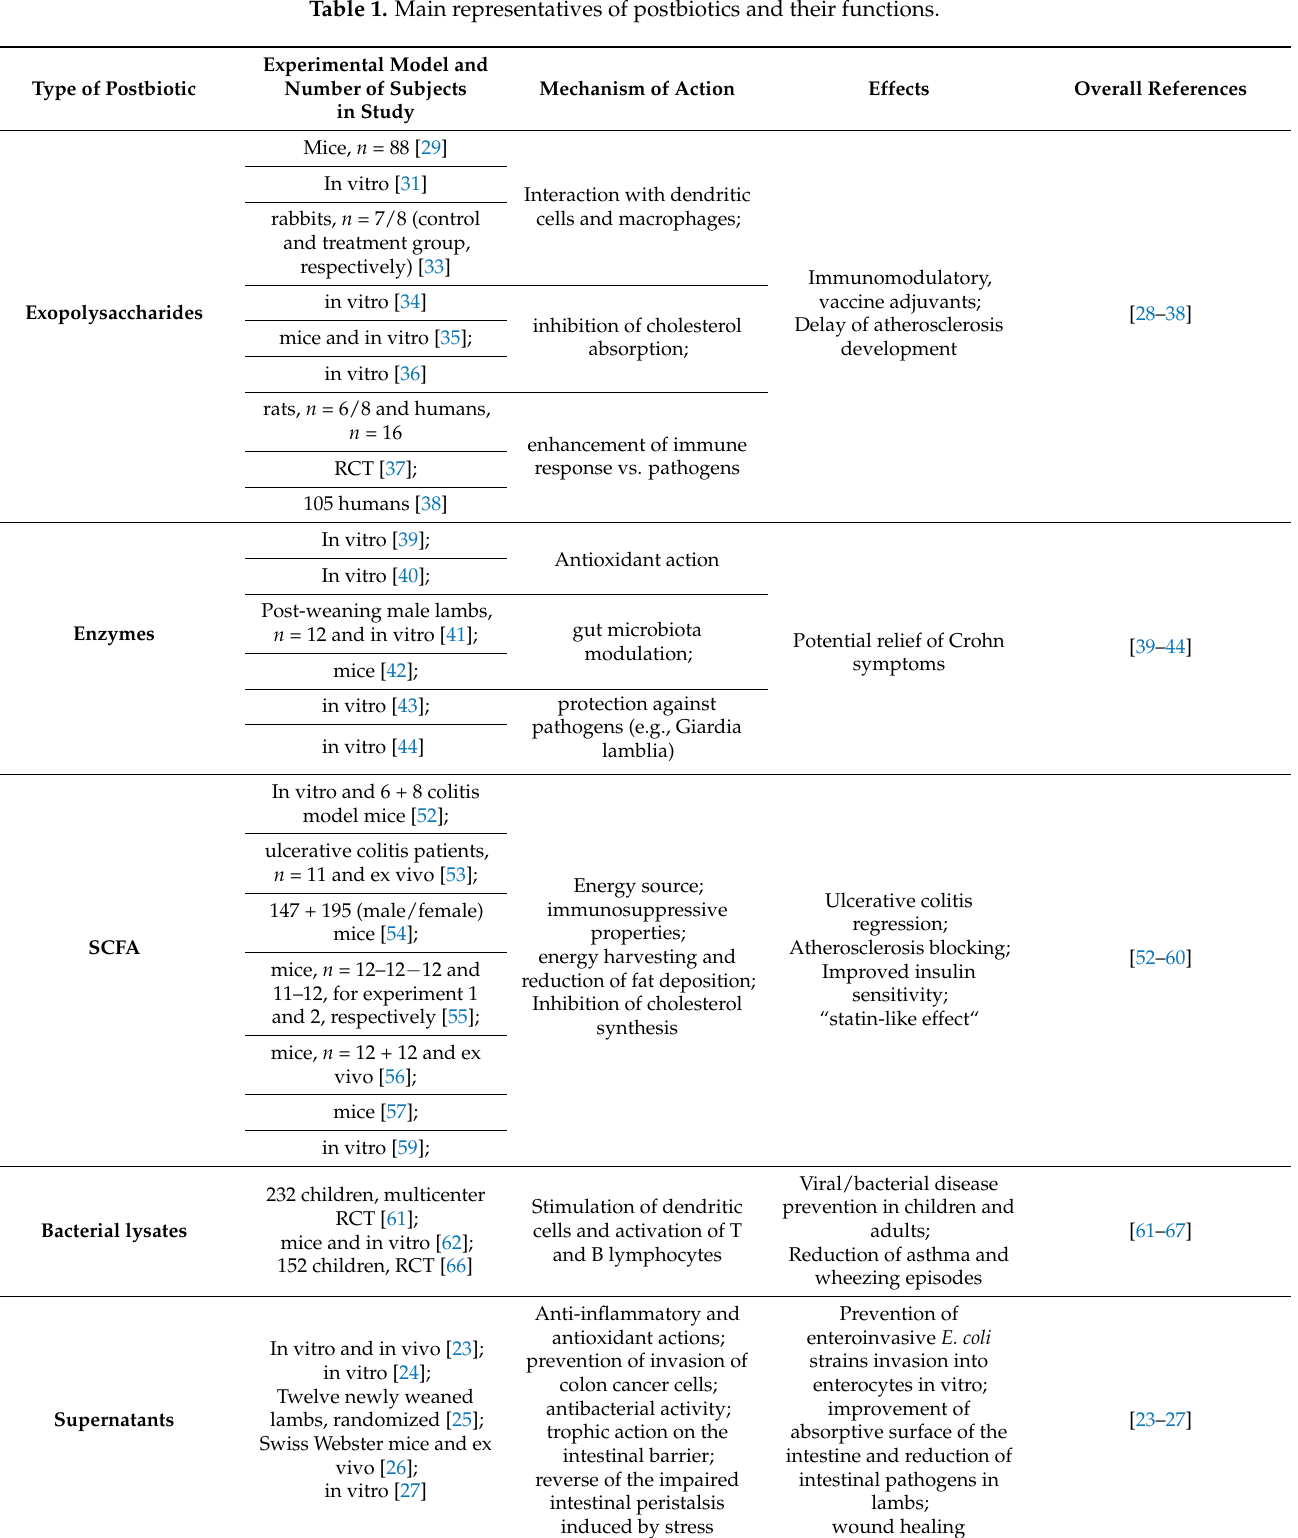
Table 1. Main representatives of postbiotics and their